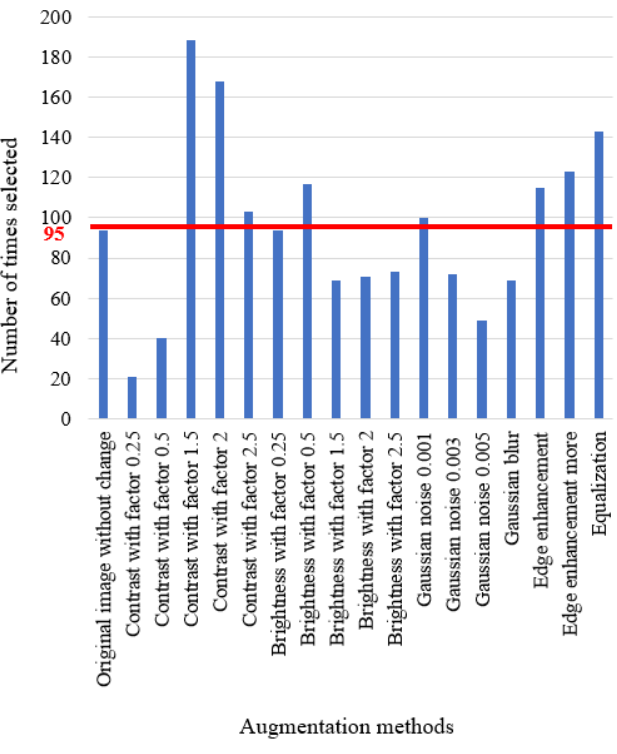
Figure 3. Augmentation